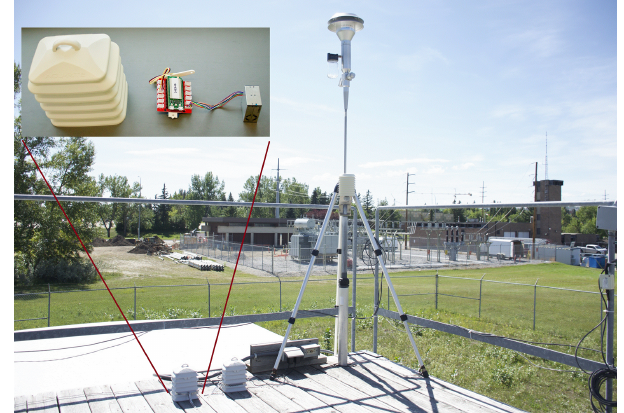
Table 1. Ambient conditions measured by